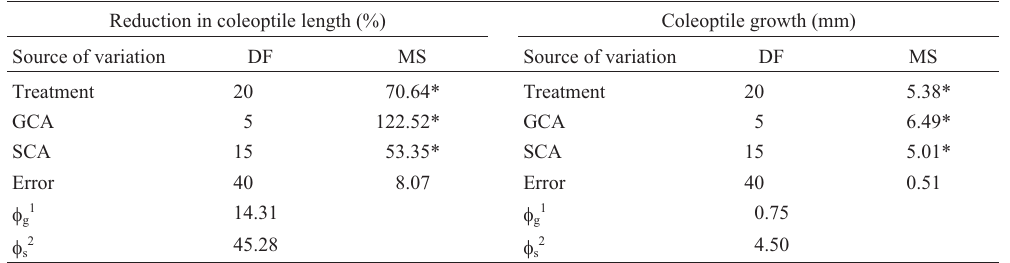
Table 2 - Analysis of variance for coleoptile length reduction (%) and coleoptile growth (mm) according to the method of Griffing (1956) in a diallel involving six rice genotypes and their F 1 hybrids.